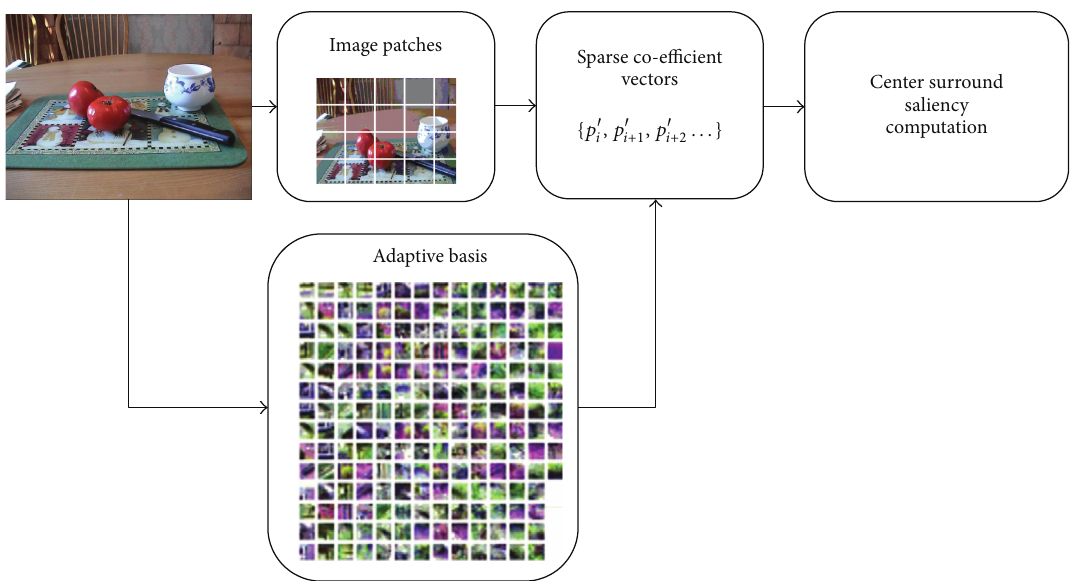
Figure 3: Saliency computation in adaptive sparse